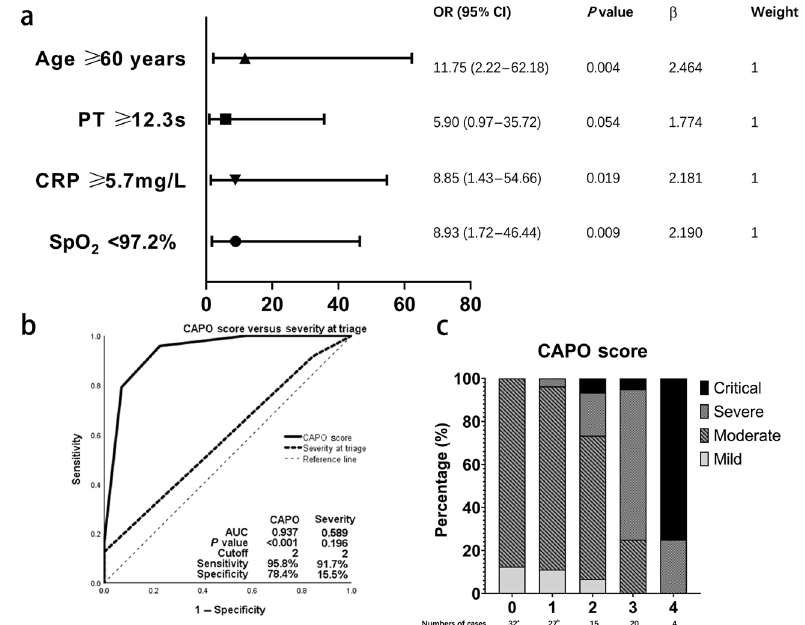
Fig. 2 Development and performance of predicting score of progression risk in patients with mild/moderate SARS-CoV-2-infection. a Multivariate analysis associated with progression to severe/critical illness. b Characteristic curves of predicting score and severity at triage for prediction of progression. c Distributions of fi nal severity strati fi cation by predicting score on admission. CRP c-reactive protein, PT prothrombin time, SpO 2 blood oxygen saturation, OR odds ratio, CAPO CRP, Age, PT, SpO 2